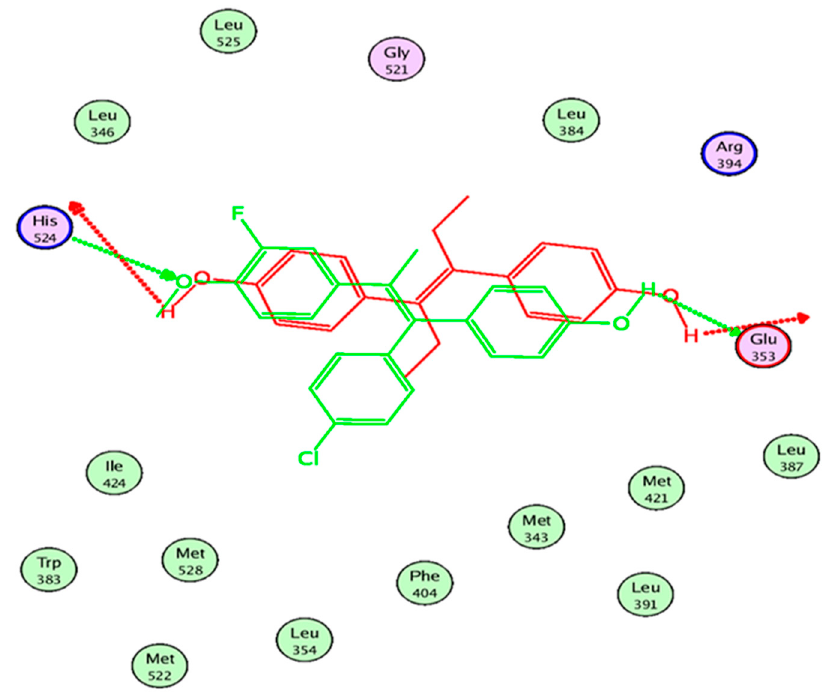
Figure 5. Two-dimensional interactions of DES ( red ) and compound 3E ( green ) inside ER α LBD .